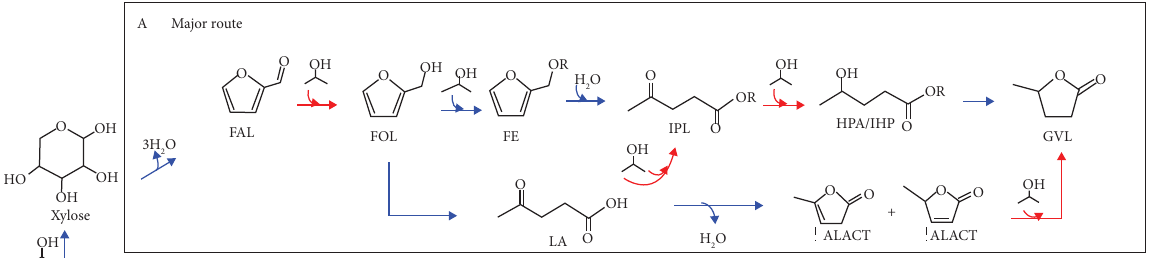
Scheme 8: Reaction mechanism for xylose conversion to c -valerolactone adopted from [50]. Key: FAL � furfural; FOL � furfuryl alcohol;